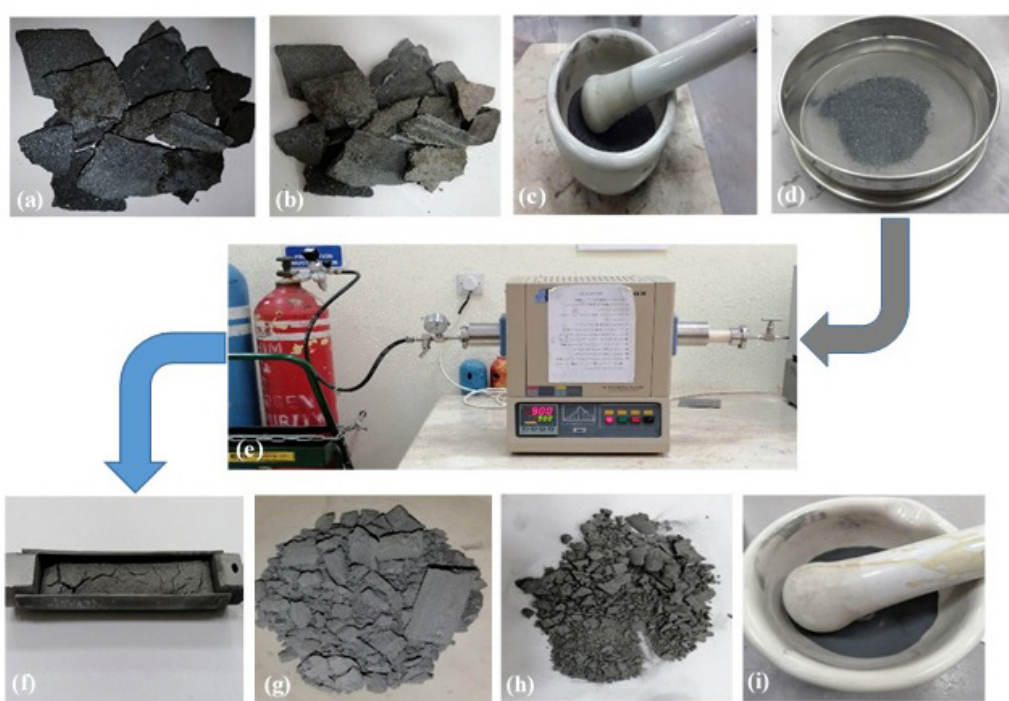
Figure 2. Schematic representation of the reduction procedure with used tools and equipment’s; (a) Mill scale, (b) Mill scale after drying at 250 o C, (c) Hand mill, (d) Sieving process, (e) Tube furnace with H2 gas system, (f) Produced iron powder, (g), (h), (i) preparation of produced iron